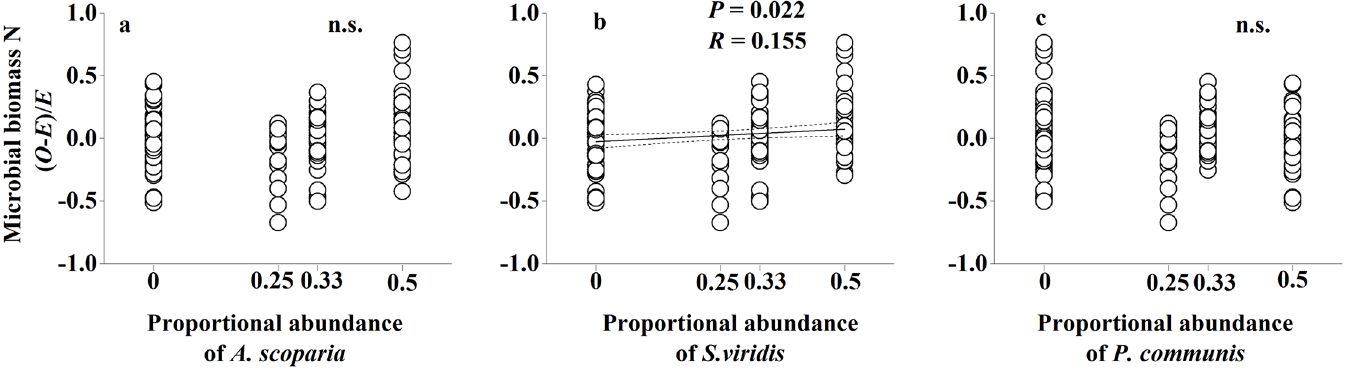
Fig 5. Non-additive soil microbial biomass N responses to mixed-species litter as a function of individual species abundance of A . scoparia , S . viridis and P . communis within the litter mixtures. Dashedlines represent the 95% confidenceinterval of the regression. O : observedvalues; E : expected values. n.s.: not significant.